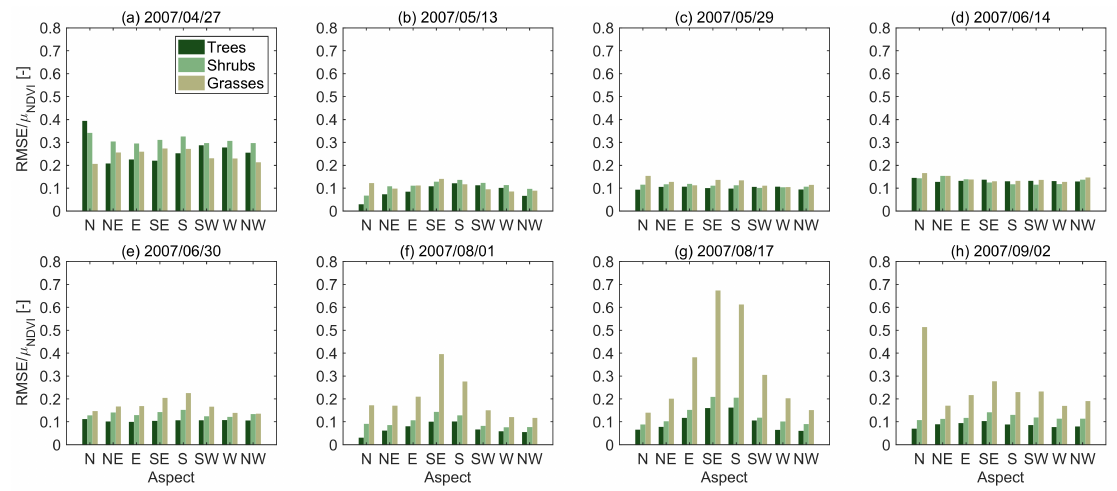
Figure 6. Normalized root mean square error ( RMSE / µ NDVI ) separated by dominant vegetation functional type and aspect over the 2007 growing season at Dry Creek Experimental Watershed (DCEW), Idaho, USA for ( a ) 27 April 2007, ( b ) 13 May 2007, ( c ) 29 May 2007, ( d ) 14 June 2007, ( e ) 30 June 2007, ( f ) 1 August 2007, ( g ) 17 August 2007, and ( h ) 2 September 2007. Errors were normalized by dividing RMSE by the mean normalized difference vegetation index (NDVI) for the given vegetation functional type on the given date (see Table 1).